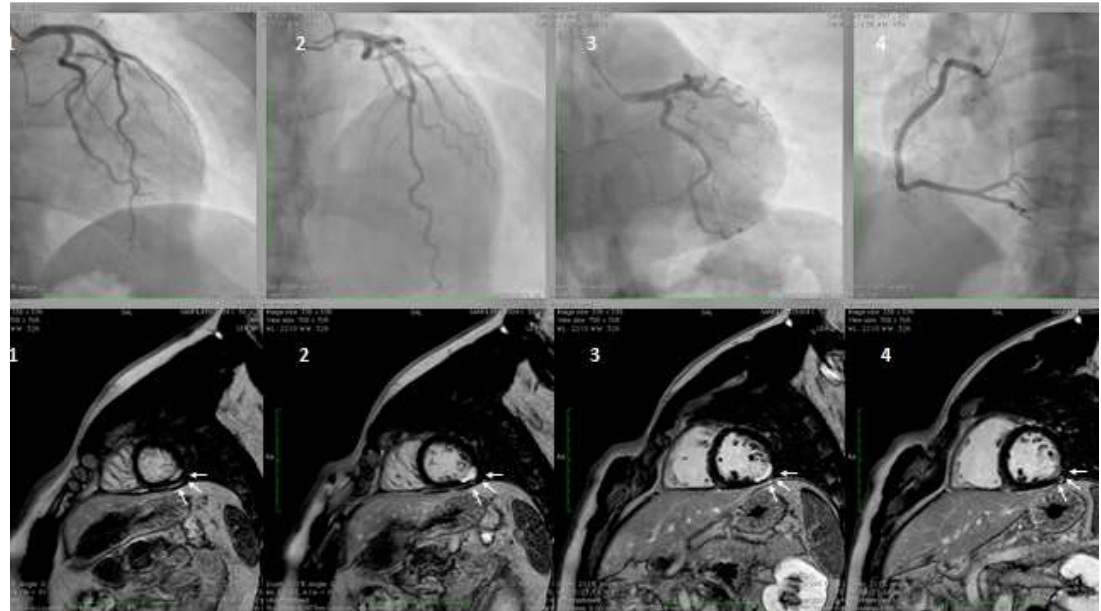
Figure 2. A hypertensive, smoker, young male patient was admitted for inferior ST-elevation myocardial infarction (STEMI). Coronary angiography was performed with no coronary lesions on the left (panel A, 1,2, and 3) and right (panel B, 4) coronary artery. Subsequentially, cardiac magnetic resonance (CMR) was performed. Delayed enhancement sequences, from apex to base, show sub-endocardial lesions (white arrows, image 1 and 4) with transmural extension (white arrows 2 and 3), confirming the ischemic lesions of the inferior-lateral wall.